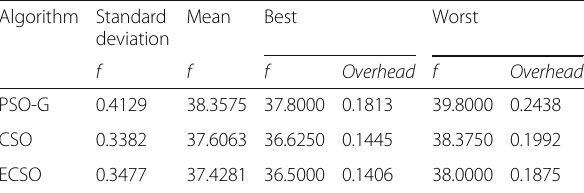
Table 5 Comparison of the optimization solutions with three algorithms for solving K32 Algorithm Standard Mean deviation